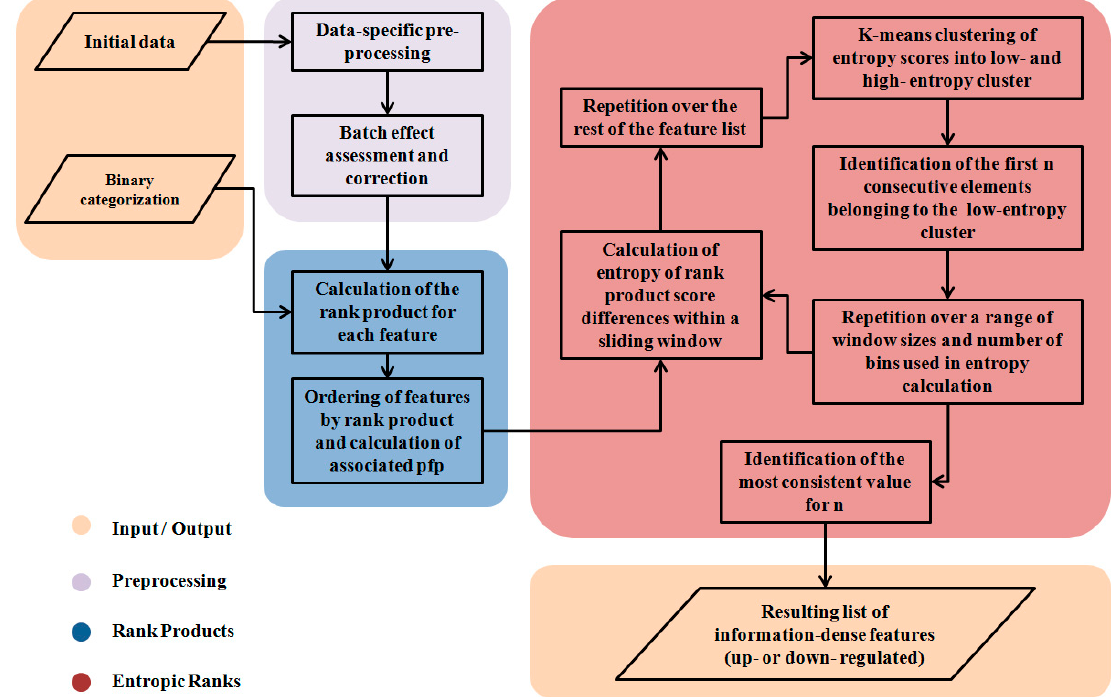
Figure 1. Entropic ranks workflow. Entropic ranks builds upon the rank products methodology and assesses its results in terms of the progression of Shannon entropy over a sliding